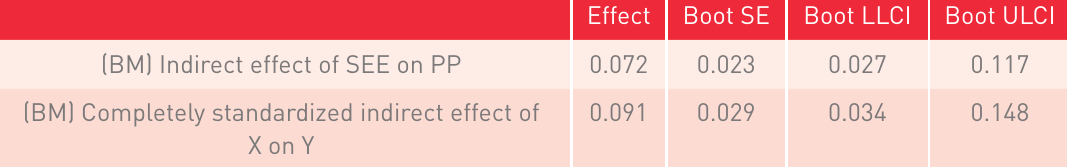
Bootstrap results